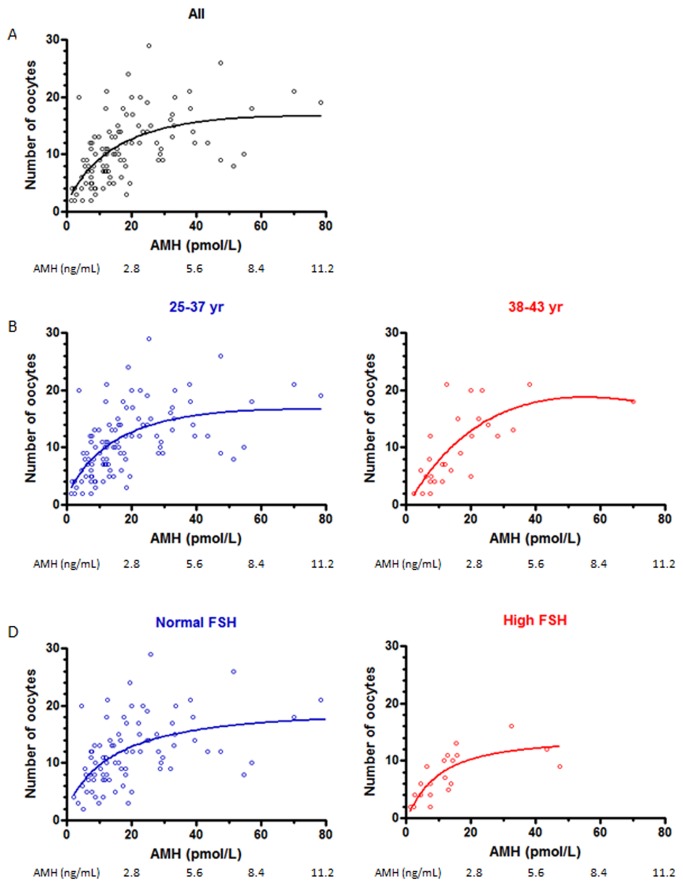
Number of oocytes retrieved at the time of aspiration as a function of AMH levels (non-linear regression).Patients were grouped according to age or FSH levels.